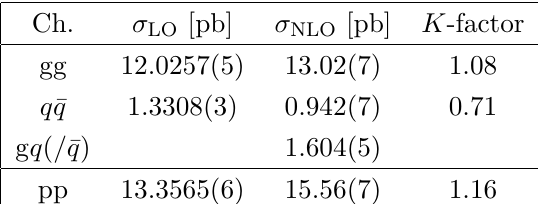
Table 1. Fiducial cross sections at LO and NLO for the process pp responding sub-channels. The possible (cid:13)avours of the quark are q = u ; d ; c ; s. The quark-gluon channels denoted by g q ( = (cid:22) q ) consist in the real corrections with gluon-quark initial states in eq. (3.1) and appear only at NLO. The proton-proton cross section is presented in the last line of the table dubbed pp. The K -factors are de(cid:12)ned as K = (cid:27) NLO =(cid:27) LO . The integration errors of the last digits are given in parentheses. The predictions are expressed in pb and are for the LHC running at a centre-of-mass energy of p s = 13